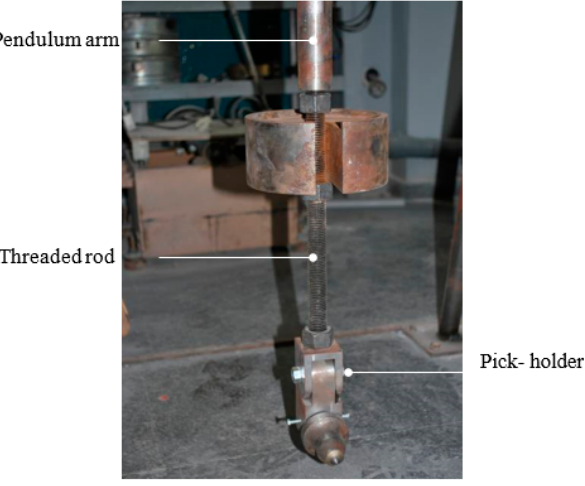
Figure 8. Pick-holder, threaded rod and pendulum arm.